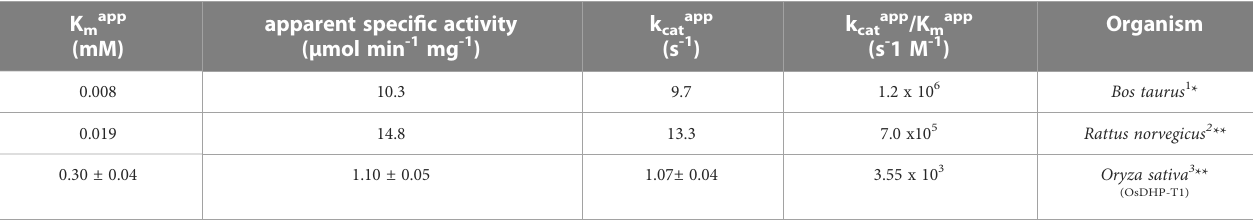
TABLE 3 Apparent kinetic parameters of dihydropirimidinases from different organisms with the substrate 5,6-dihydrouracil. K